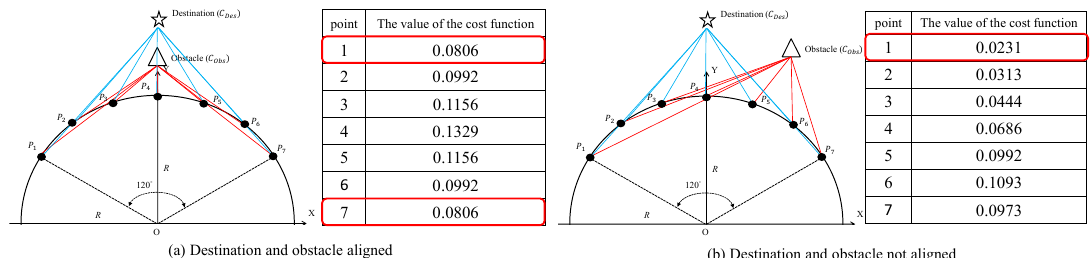
Figure 8. Destination and obstacle aligned and not aligned.